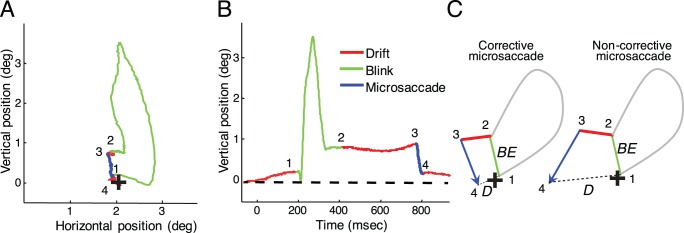
Blink-induced fixation errors.(A) Eye position trace showing an example of a blink (green) followed by drift (red) and then a microsaccade (blue). The black cross represents the fixation target. The eye position at the end of the blink (2) does not match the fixation target (black cross). A microsaccade corrects the error by bringing the eye from position (3) to (4), closer to the fixation target. (B) Vertical eye position for the same trace. The dashed line represents the fixation target. (C) Cartoons of corrective and non-corrective microsaccades. BE (dashed line) indicates the blink-induced fixation error and D (dotted line) the distance between the eye position at the end of the microsaccade and the fixation target. Left: the microsaccade reduces the blink-induced eye position error (D is shorter than BE). Right: the microsaccade increases the eye position error (D is longer than BE).